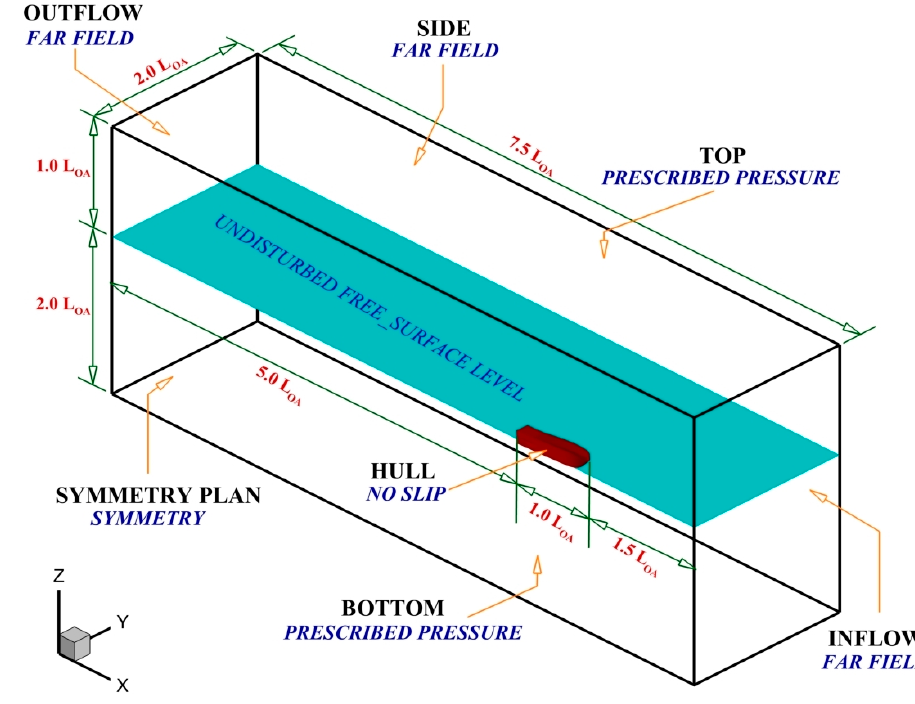
Figure 3. Computational domain and boundary conditions.